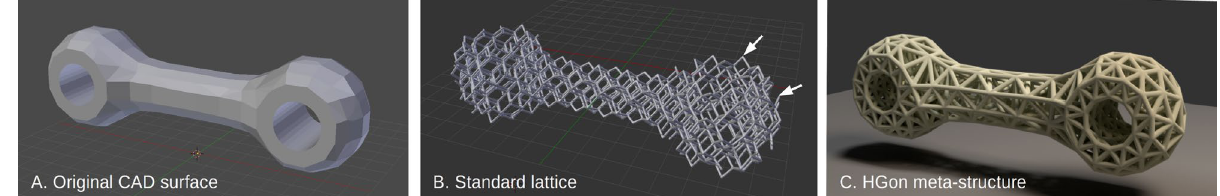
Figure 1. ( A ) CAD surface model of a linkage, ( B ) standard BCC lattice, and ( C ) a new HGon meta-structure. The standard periodic lattice shows common problems of multiple ‘hanging’ struts and edges (arrows) which require manual correction. In contrast, the HGon meta-structures automatically conform precisely and accurately to the original CAD surfaces, edges, and holes with little or no correction required.